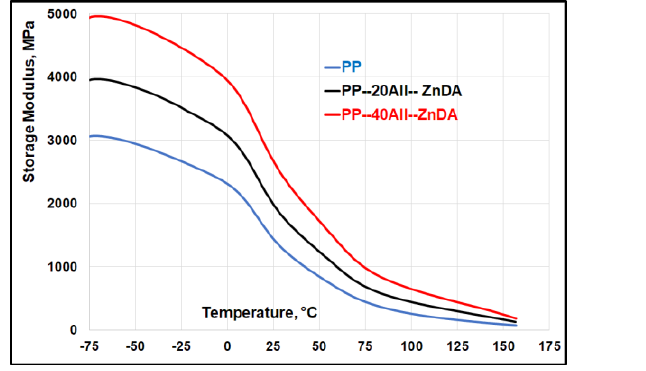
Table 5. Comparative values of storage modulus (E’) at different temperatures for the neat PP and PP – AII composites modified by REx.